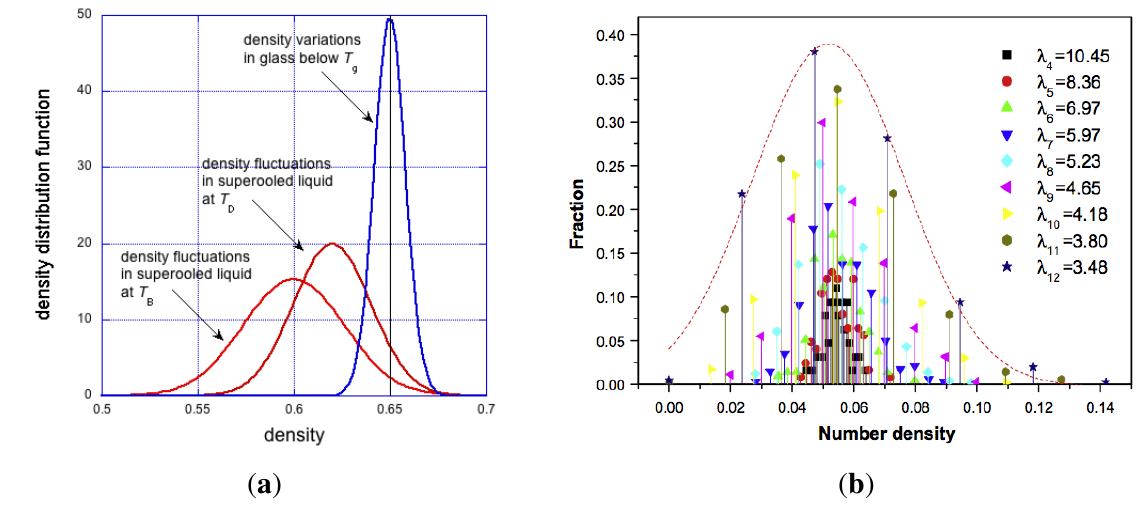
Figure 8. On the left: hypothetical density distribution in supercooled liquid at two different temperatures and in glass. On the right, density distribution in metallic glasses, reproduced from